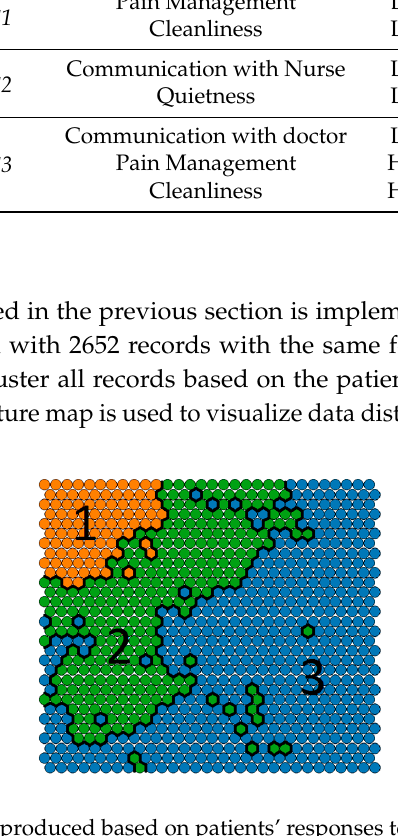
Figure 2. The clusters produced based on patients’ responses to satisfaction questions.